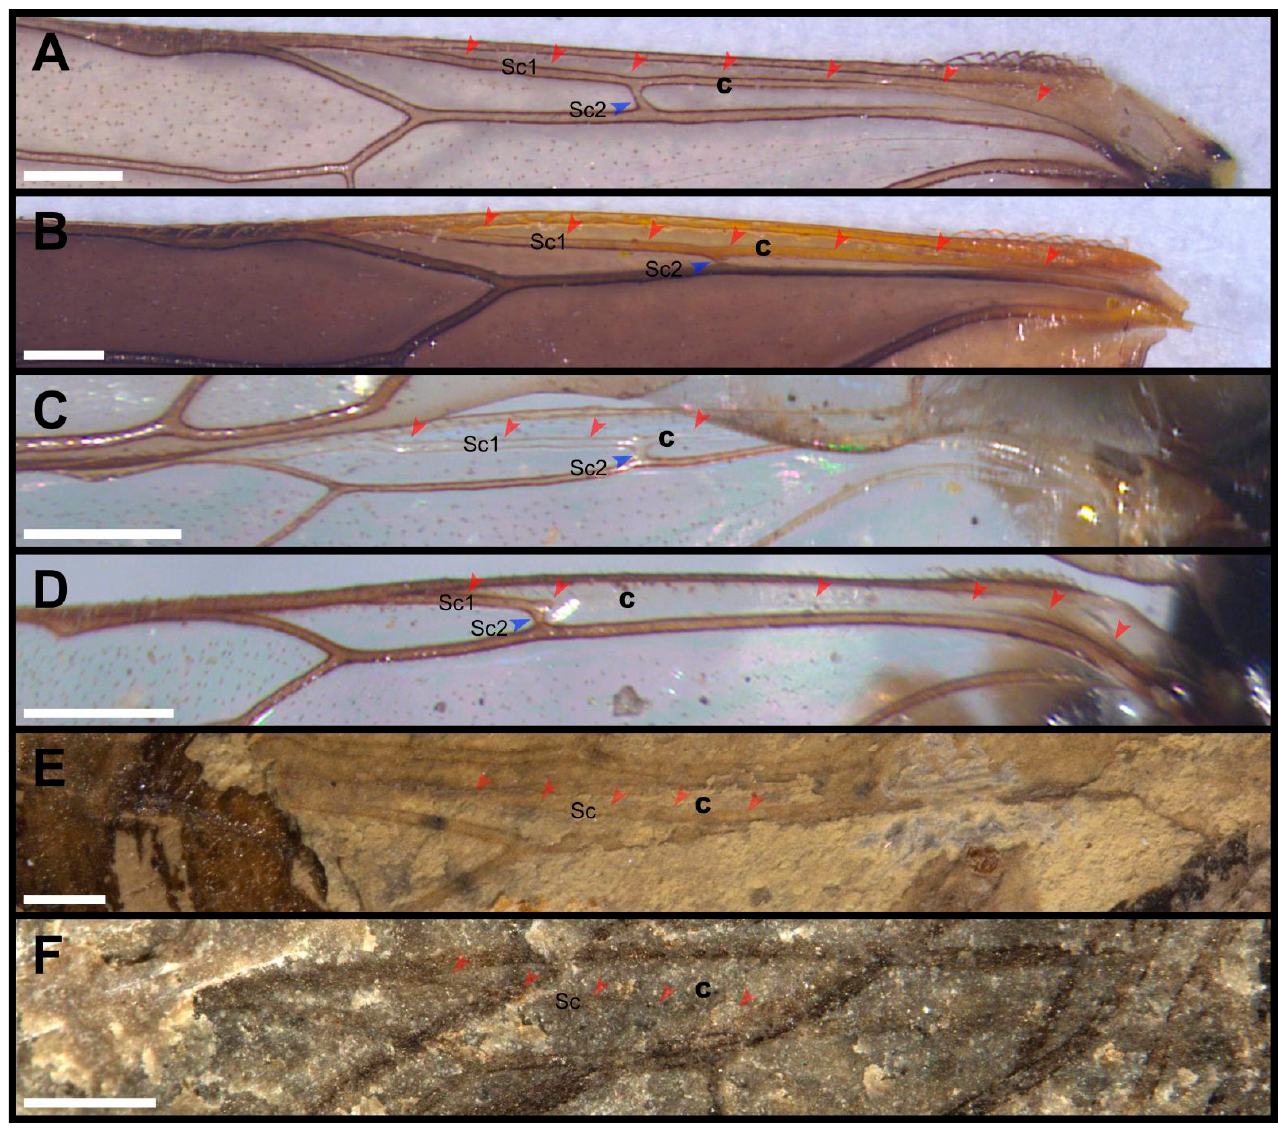
Figure 7. Sc in hind wings of Pamphiliidae. ( A ), Acantholyda posticalis Matsumura, 1912, ♀ (Cephalciinae). ( B ), Cephalcia yanqingensis Xiao, 1987, ♀ (Cephalciinae). ( C ), Pamphilius ignymonriensis Lacourt, 1973, ♂ (Pamphiliinae). ( D ), Neurotoma sibirica Gussakovskij, 1935, ♀ (Pamphiliinae). ( E ), Scabolyda latusa Zhuang, Shih, Wang and Ren, 2022, ♀ (Juralydinae). ( F ), Dolicholyda angusta sp. nov., ♀ (Juralydinae). Cell c are in bold. Arrows here mean the venations are highlighted. Scale bars: 0.5 mm in ( A – F ).